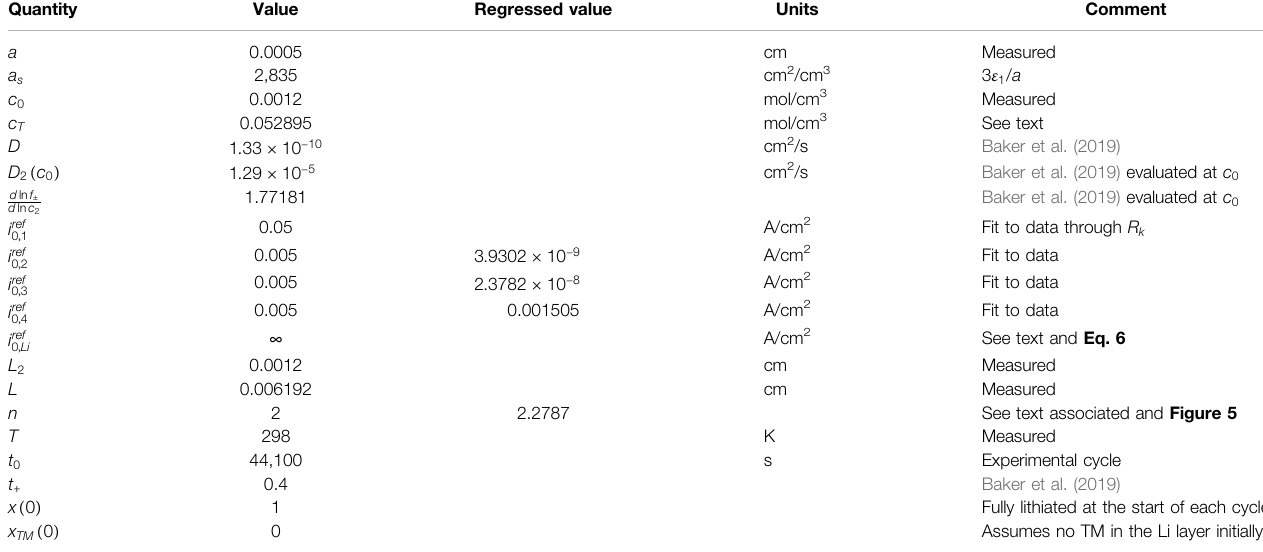
TABLE 1 | Parameters and properties used in the simulations. For parameters that were regressed to fi t the data (cf. Figure 7 ), the regressed values are provided. Quantity